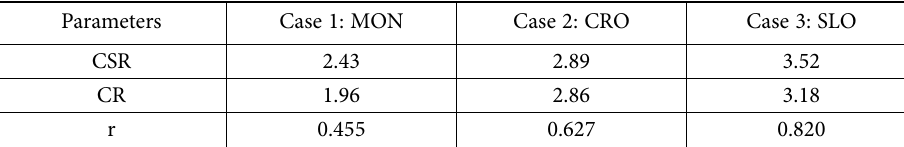
Table 6. Correlation between CSR and